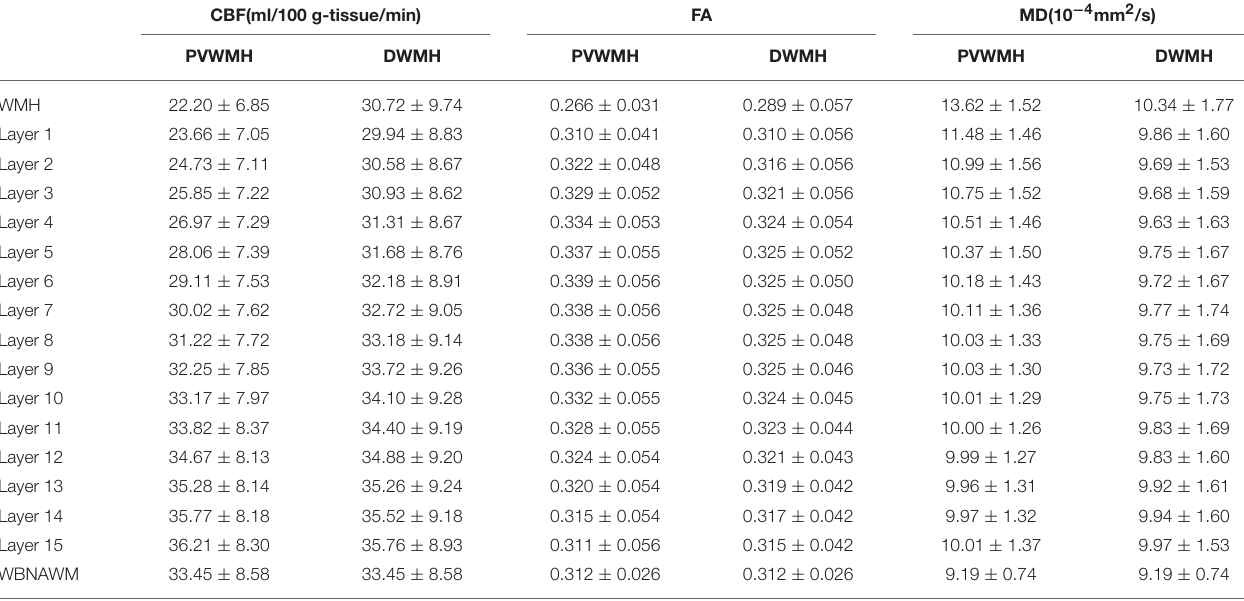
TABLE 3 | The mean FA, MD, and CBF values of the PVWMH, DWMH, and their corresponding layers (mean ± SD). CBF(ml/100 g-tissue/min) FA MD(10 − 4 mm 2